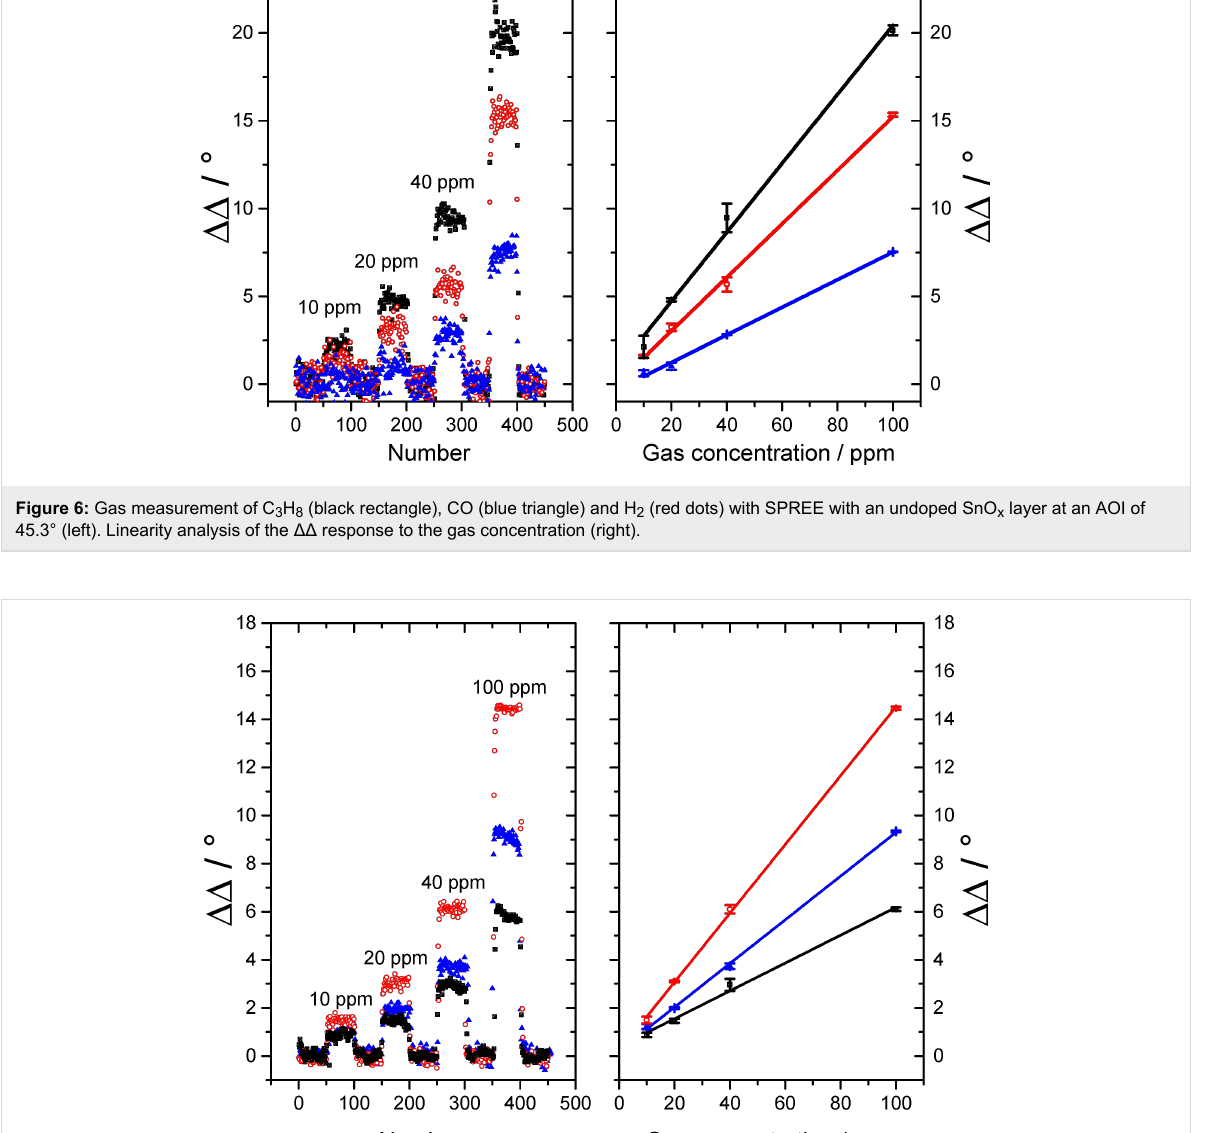
than CO.In contrast, the response to H 2 is driven by an in- creased diffusion into the sensing layer in contrast to an adsorp- tion at the surface due to the small molecule size [32]. To support the theory of a dependence of the binding sites to the response in the gas measurement, iron doped tin oxide (Fe:SnO x ) overcoated sensors with an increased number of binding sites for CO were built [33]. This was achieved by adding a block of metallic iron to the target. A gas sensing mea- surement using a SPR setup with this coating is shown in